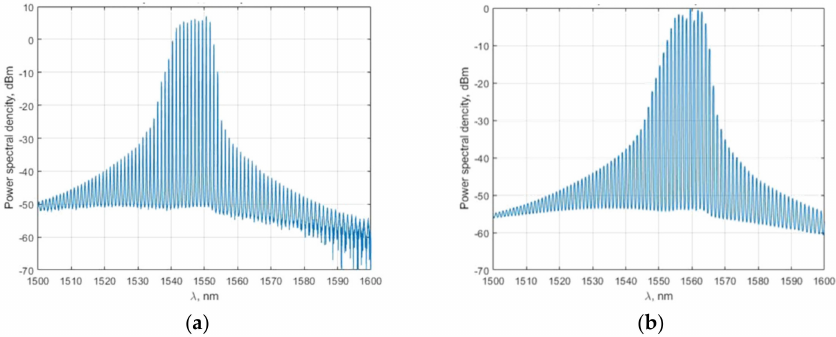
Figure 6. Spectra of Fabry-Perot laser diodes used in a